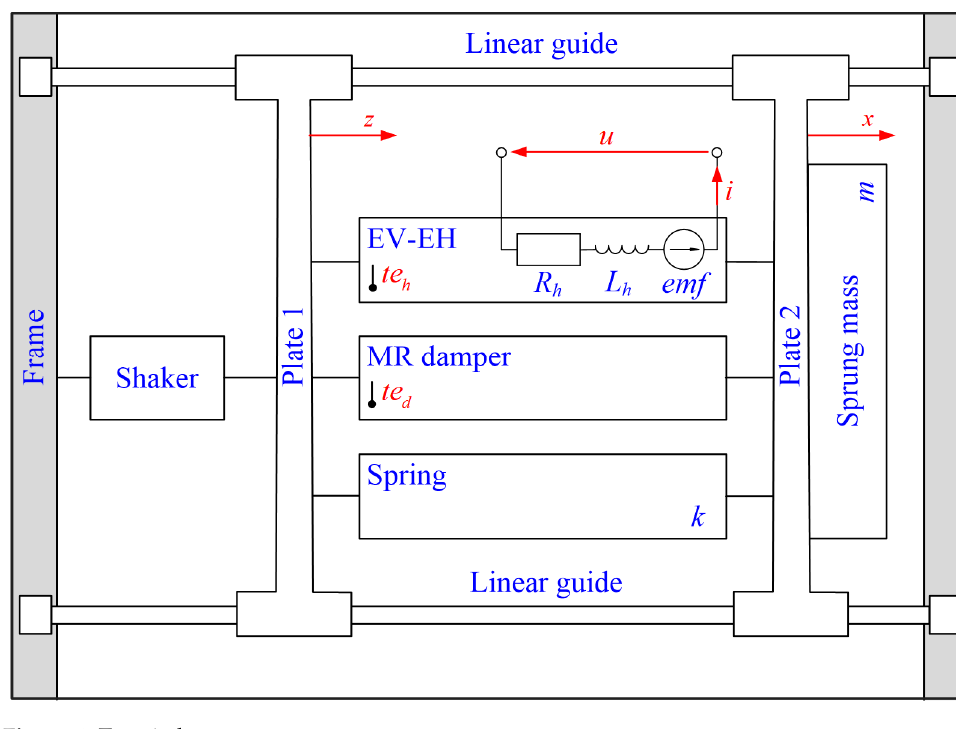
Figure 4. Test rig layout.